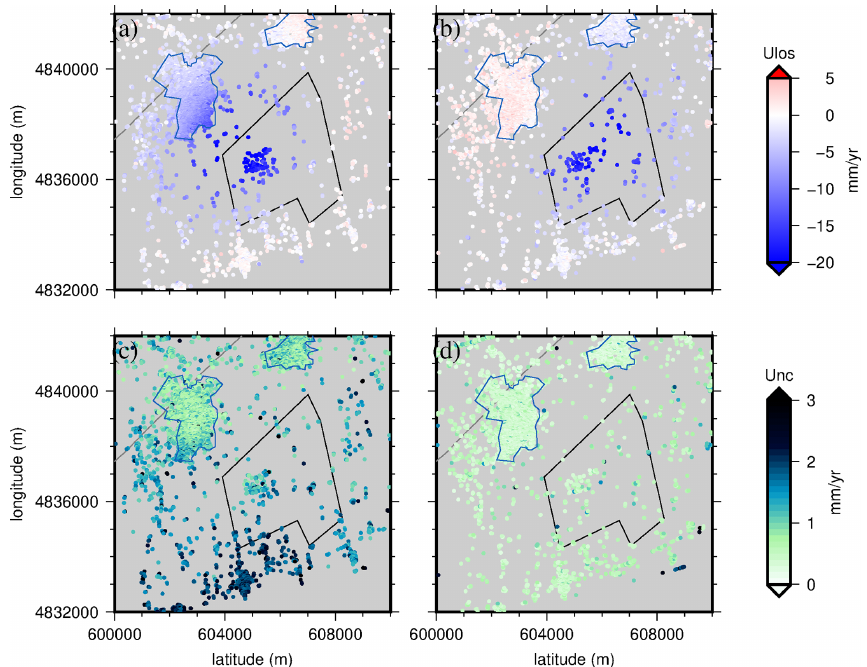
Figure 4. Mean velocity in LOS direction in (a) ascending and (b) descending interferograms over the area of interest and their associated uncertainties (c) and (d) , respectively. Ascending geometry is characterized by a flight direction with respect to the north of 103.96 ◦ and an incidence angle of 32.93 ◦ . Descending geometry is defined by a flight direction with respect to the north of 256.01 ◦ and an incidence angle of 36.98 ◦ . The polygons represent the extent of Vauvert and Beauvoisin cities (blue polygons) and the KemOne company area (black polygons; see Fig.